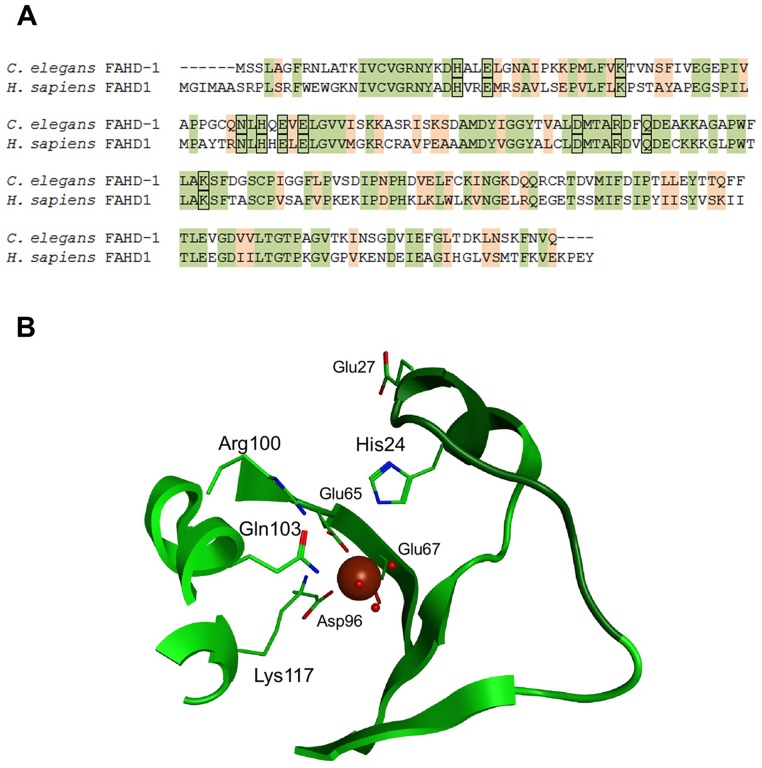
ZK688.3 is the nematode homolog of FAHD1.(A) The hypothetical protein ZK688.3 (NP_498715.1; now FAHD-1) was identified as the only C. elegans ortholog of human FAHD1 by BLAST search (E value of 9e-71; http://blast.ncbi.nlm.nih.gov/), and confirmed by reverse BLAST. A comparison of the amino acid sequences revealed 47% identity between the two proteins. Amino acids relevant for the ODx function of FAHD1 are boxed. (B) Conserved residues (shown as sticks) arrange as known from FAHD1 or Cg1458. The central magnesium ion (brown sphere) is coordinated by the negatively charged Glu65, Glu67 and Asp96. Around the catalytic site typical fold elements of the protein backbone are shown as ribbon.